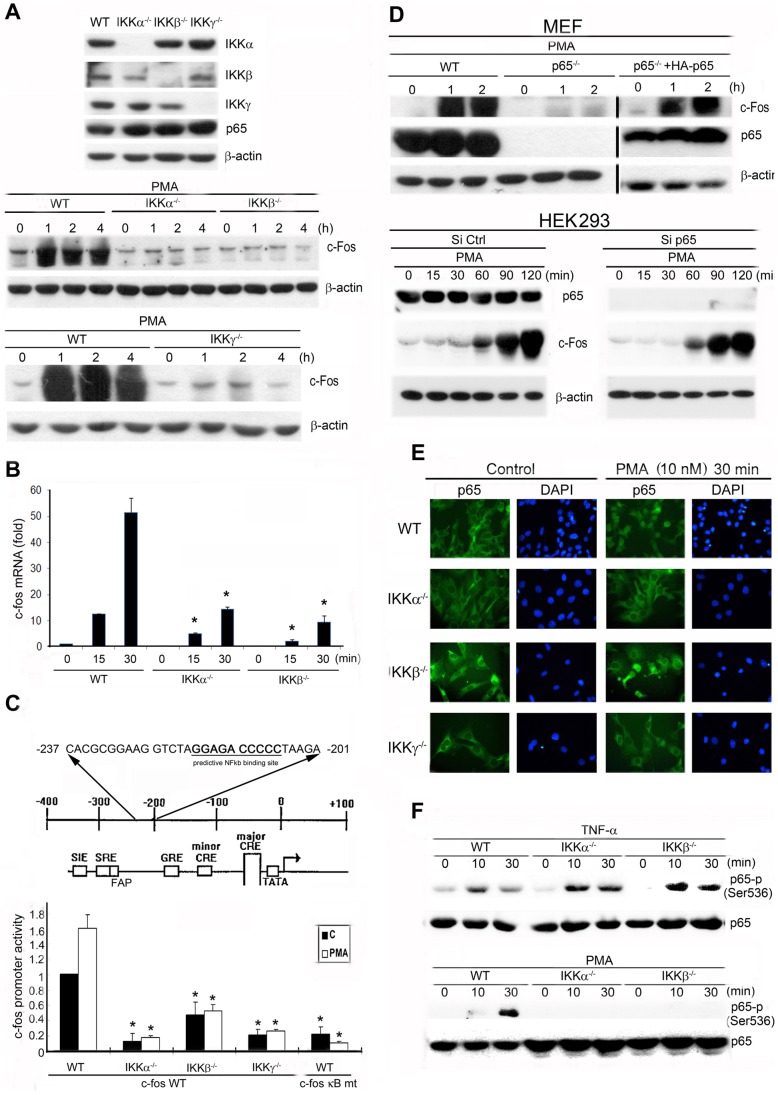
The IKK complex is involved in PMA-induced p65 phosphorylation and nuclear localization and c-Fos expression.In most experiments, WT, IKKα−/−, IKKβ−/−, IKKγ−/−, and p65−/− MEFs were treated with TNF-α (20 ng/mL) or PMA (10 nM) for the indicated times. (A, D, F) Total cell lysates were prepared and subjected to western blotting analysis; the antibodies used are indicated. The western blots are representative of 3 independent experiments. (B) Total RNA was extracted, reverse transcribed into cDNAs, and subjected to qPCR analysis. Values were normalized relative to β-actin gene expression and expressed relative to the control sample. * P<0.05 indicates a significant reduction in PMA-induced gene expression in IKK-null MEFs. (C) Distinct response elements and the predicted NF-κB-binding site in the mouse c-fos promoter are shown. Regulatory elements identified in the mouse c-fos promoter are labeled and include the cis-inducible elements SRE, Fos activator protein 1 site (FAP), a glucocorticoid response element (GRE), and CRE. The major CRE is nearest of the sites to the start site within the large box, whereas the minor CREs are further upstream and are denoted using small boxes. Constitutive activity of the c-fos promoter with or without mutation of the κB site was determined in WT and IKK-null MEFs. Data in (B) and (C) are the means ± SEM from 3 independent experiments. * P<0.05 indicates a significant reduction in basal and PMA-induced promoter activity in IKK-null MEFs. (D) The p65−/− MEFs were reconstituted with p65 protein, and HEK293 cells were transiently transfected with control or p65 siRNA (100 nM) for 48 h. Cells were treated with PMA for the indicated times. (E) Immunofluorescent staining of p65 (green) and nuclei (blue) shown by images captured under a fluorescence microscope; similar results were obtained in 2 additional experiments.